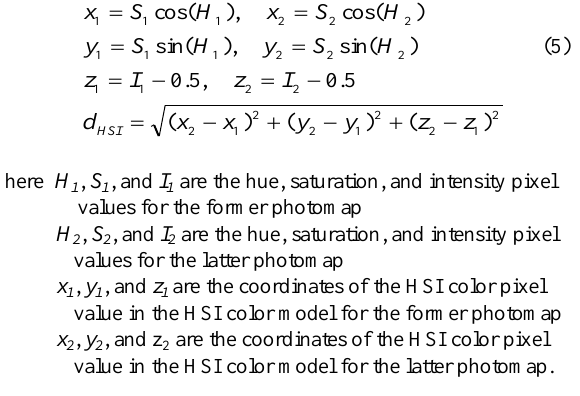
Fig.1. The color changed values were calculated each same pixel coordinate on photomaps of two separate times. For example, the red arrow in Fig.1 shows d HSI when the color changes from blue to